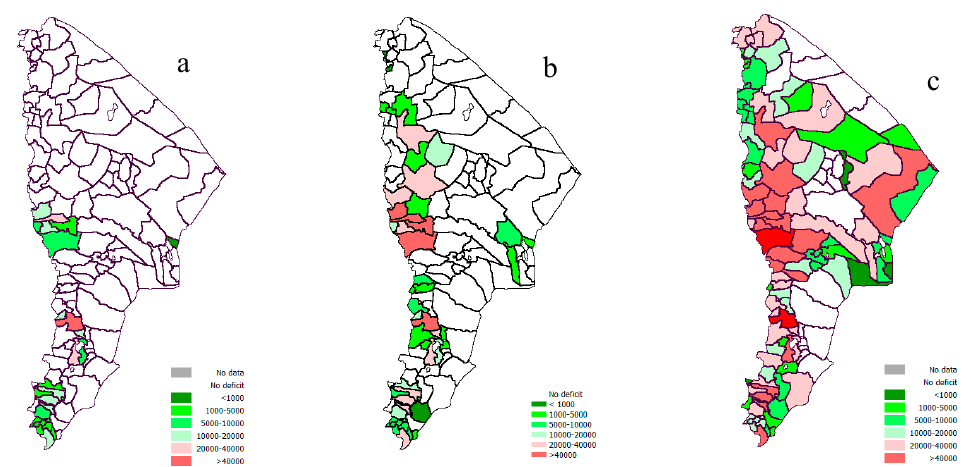
Figure 17. Feed deficits: ‘Best’ (panel a ), ‘Base’ (panel b ) and ‘Worst’ (panel c ) scenarios (scale 1:7,200,000)